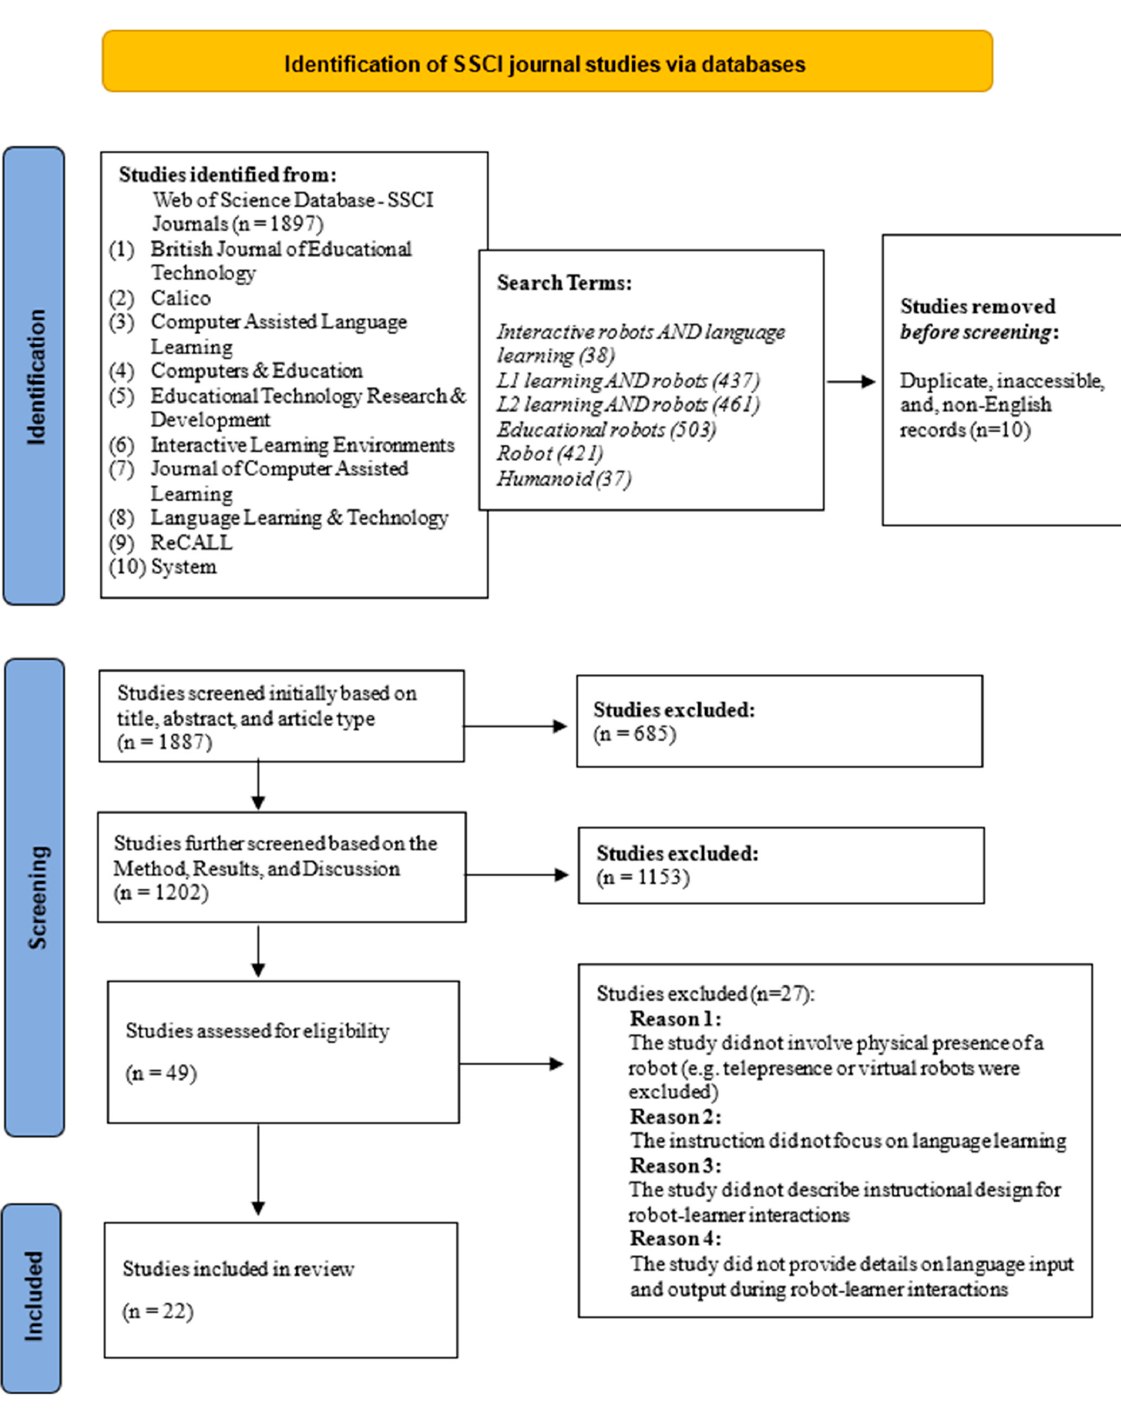
Figure 1. PRISMA flow chart showing the selection process (available online: http://www.prisma- statement.org/ (accessed on 7 March 2021).